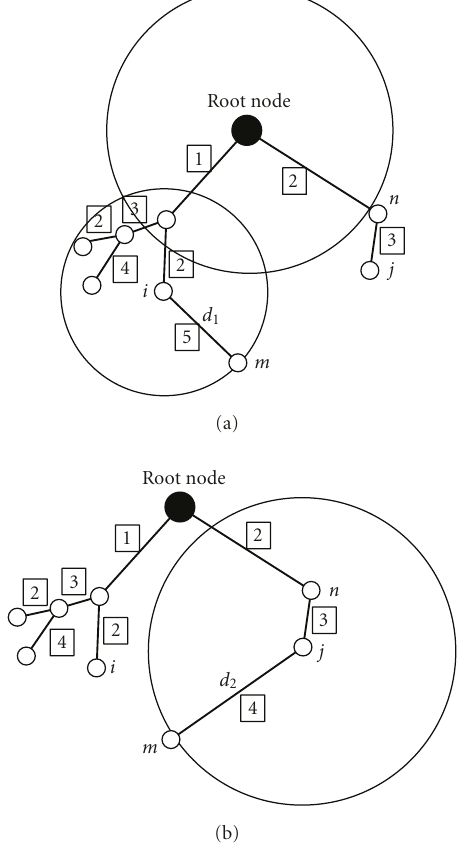
Figure 3: (a) Minimum power spanning tree (MPST), and (b) a spanning tree that requires less number of timeslots (better spatial reuse). Timeslots are shown within the rectangular boxes.